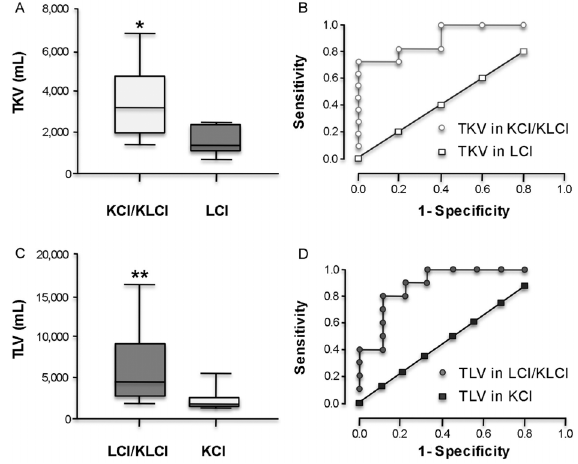
Figure 5. Association between organ volume and cyst infection. A , Patients admitted to the hospital with KCI/KLCI presented higher TKV in comparison with those with isolated LCI [3491 mL (2136- 5167; p25-p75) vs 1021 mL (745-2157; p25-p75)] (*P , 0.05, Mann- Whitney test). B , Receiver operating characteristic curve (ROC) analysis for TKV. The highest accuracy point for KCI was TKV=2502 mL, with 72.7% sensitivity and 100.0% specificity (AUC=0.91, 95%CI=0.76-1.06, P=0.013). C , Patients with